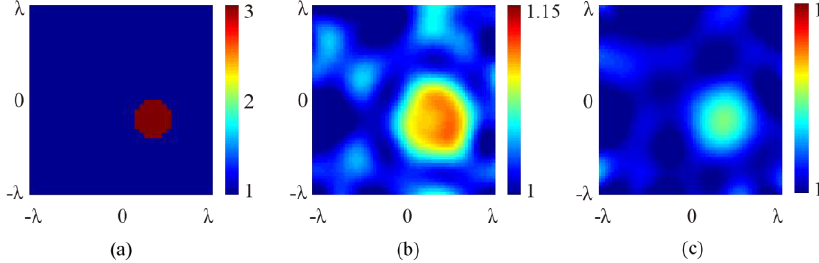
Figure 7. The retrieved cross-section profile of the off-centered 2D cylinder using first order Born approximation. ( a ) Original profile; ( b ) retrieved result at 15° angle of incidence; and ( c ) retrieved result at 30° angle of incidence.